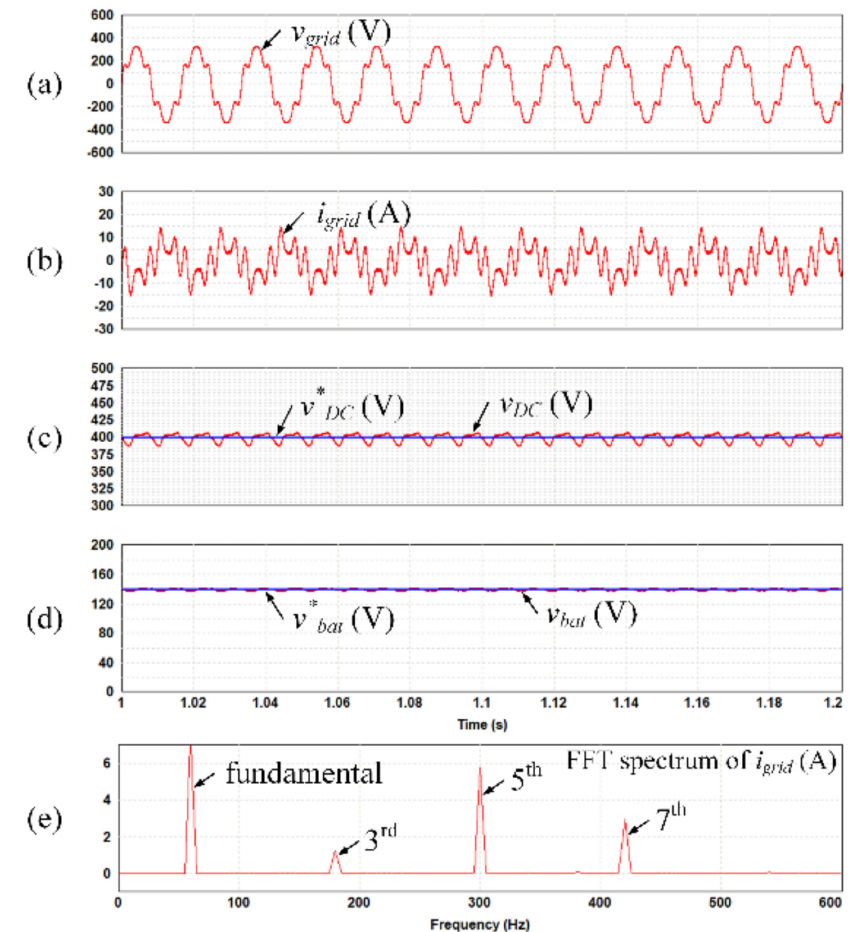
Figure 9. Simulation results of integrated OBC with fifth-order and seventh-order harmonic com- ponents in a single-phase grid source: ( a ) voltage and ( b ) current of the single-phase grid source, ( c ) DC-link voltage and reference DC-link voltage, ( d ) voltage of the battery and reference voltage of the battery, and ( e ) FFT spectrum of current of the single-phase grid